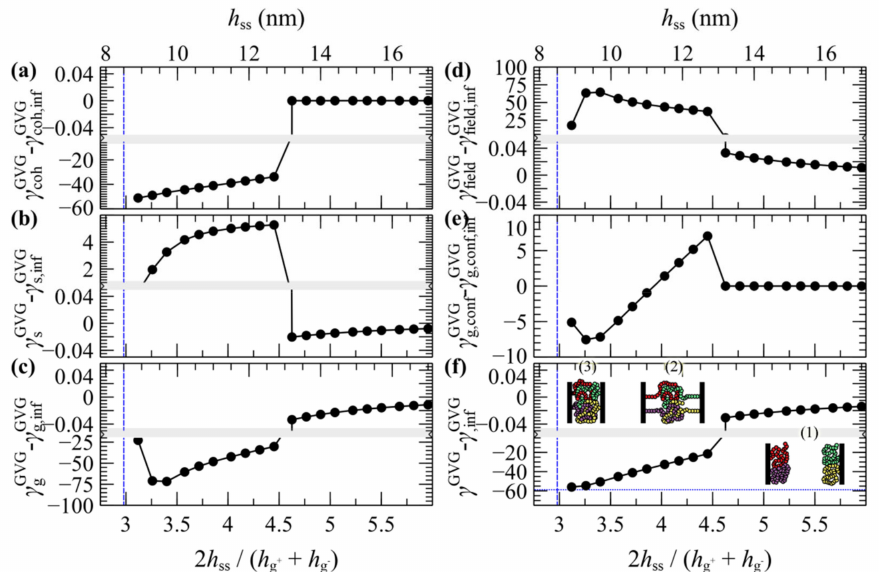
Figure 15. Free energy partial contributions to the potential of mean force for two approaching grafted surfaces with σ g = 0.2 nm –2 and N g = 192 in vacuum: ( a ) cohesive interactions, ( b ) polymer-solid interactions, ( c ) entropic contribution from grafted chains, ( d ) density-field interactions, ( e ) stretching contribution from grafted chains and ( f ) total grand potential. The vertical lines denote plate-plate distances where the reduced density exceeds unity. The horizontal dotted (cid:16) (cid:17) γ G − V + γ VG + line in ( f ) depicts − 0.5 . The insets in ( f ) depict configurations across the 1st, 2nd and 3rd regime. Bands denote scale changes along the